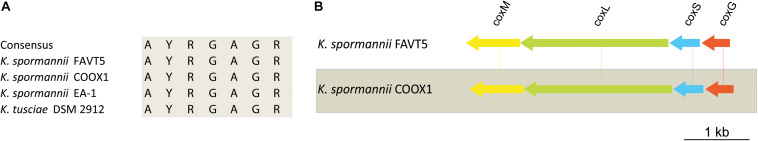
(A) Multiple sequence alignment of the active site of Form II CO dehydrogenase of the different Kyrpidia species. (B) Gene arrangement of the CO dehydrogenases in K. spormannnii FAVT5 and K. spormannii COOX1. Genes are color coded as follows: green = large subunit, blue = small subunit, yellow = medium subunit, orange = accessory protein.